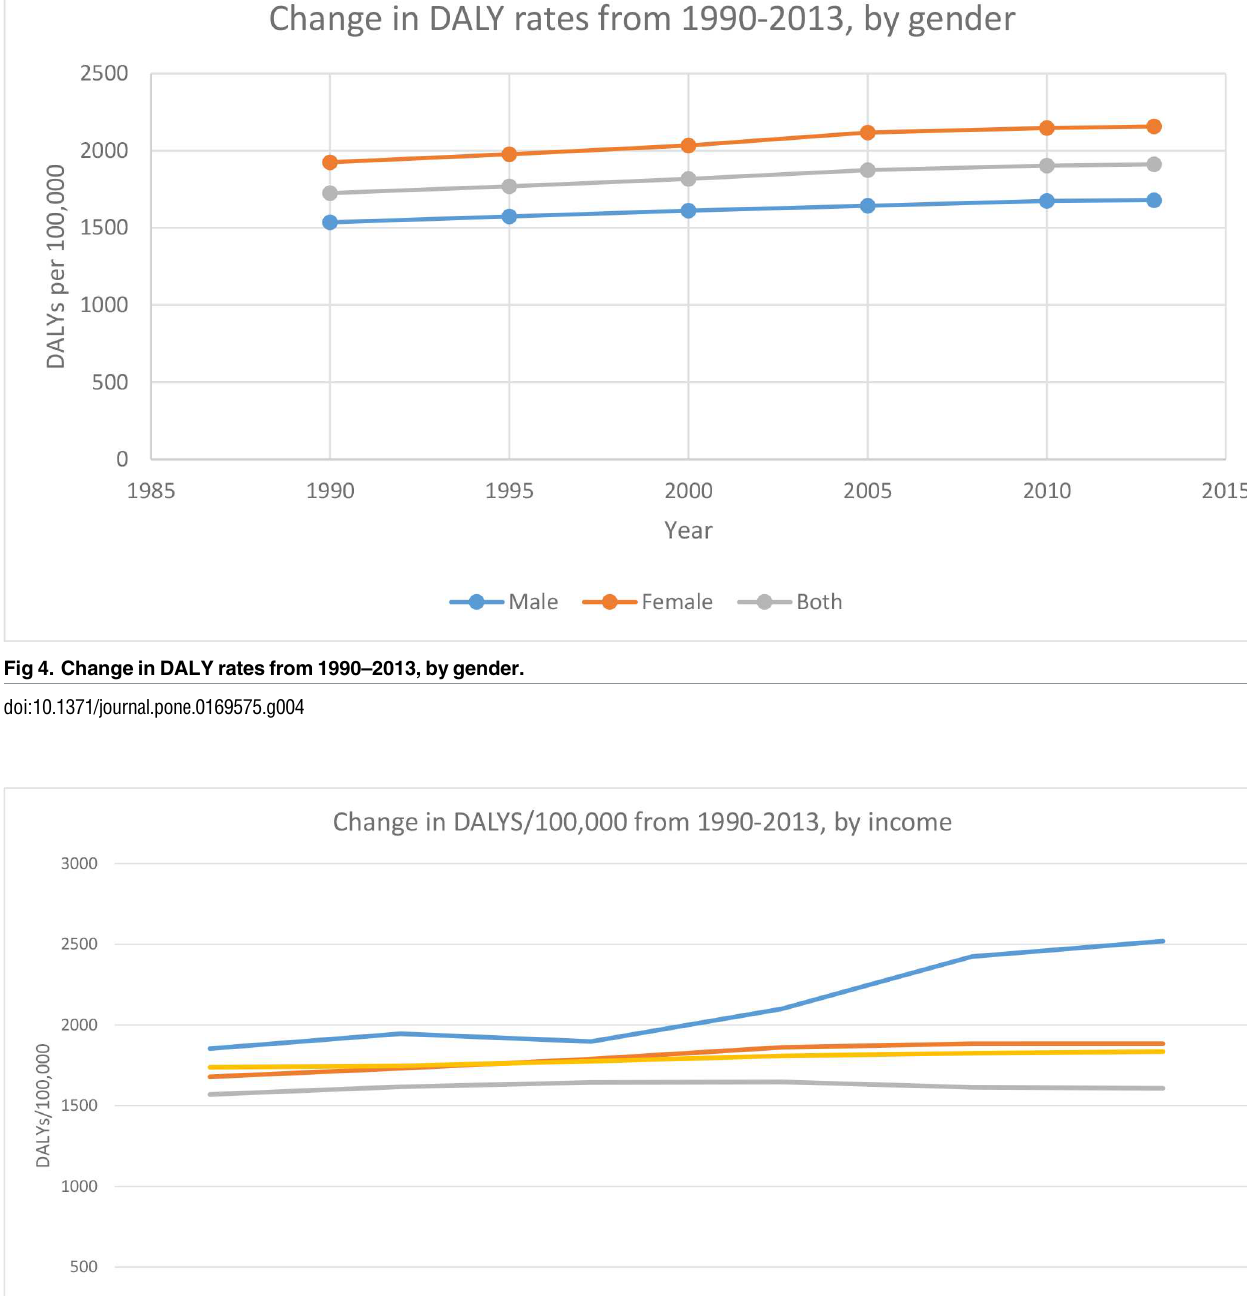
PLOS ONE | DOI:10.1371/journal.pone.0169575 January17,